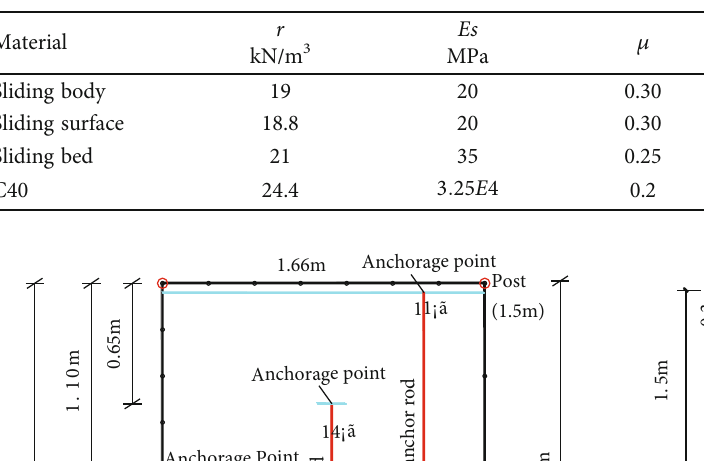
Table 1: Physical and mechanical parameters of the test material.